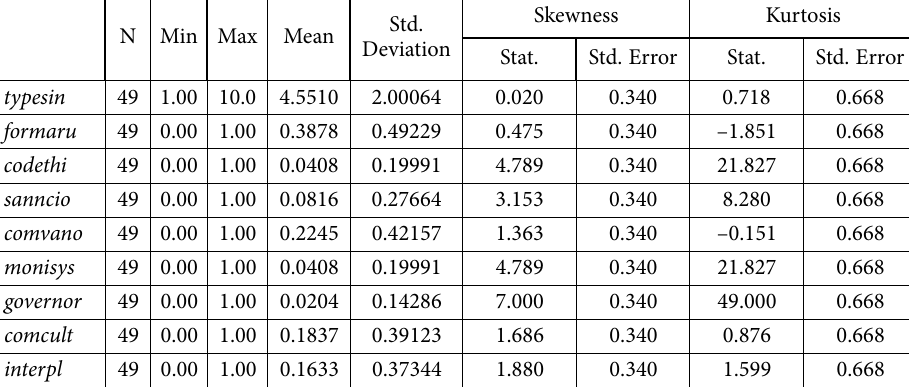
Table 4. Descriptive statistics – H2 (source: authors’ compilation) Std. N Min Max Mean Deviation